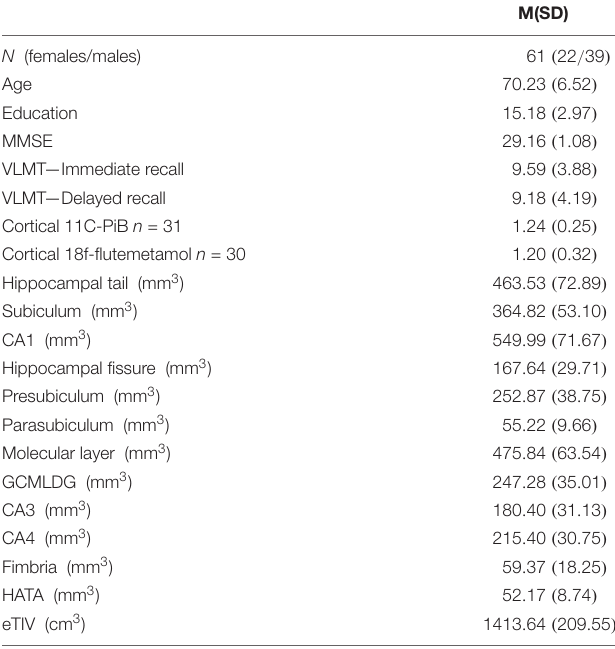
TABLE 1 | Demographic and other descriptive